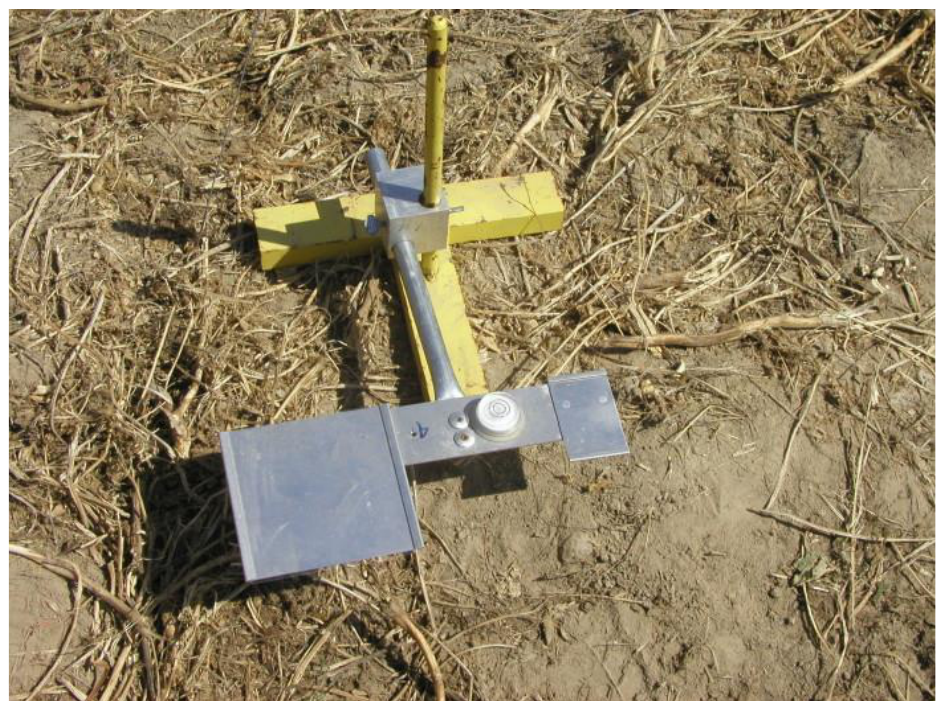
Figure 1. Field sampling stand. Mylar sheets are held on the left bracket.